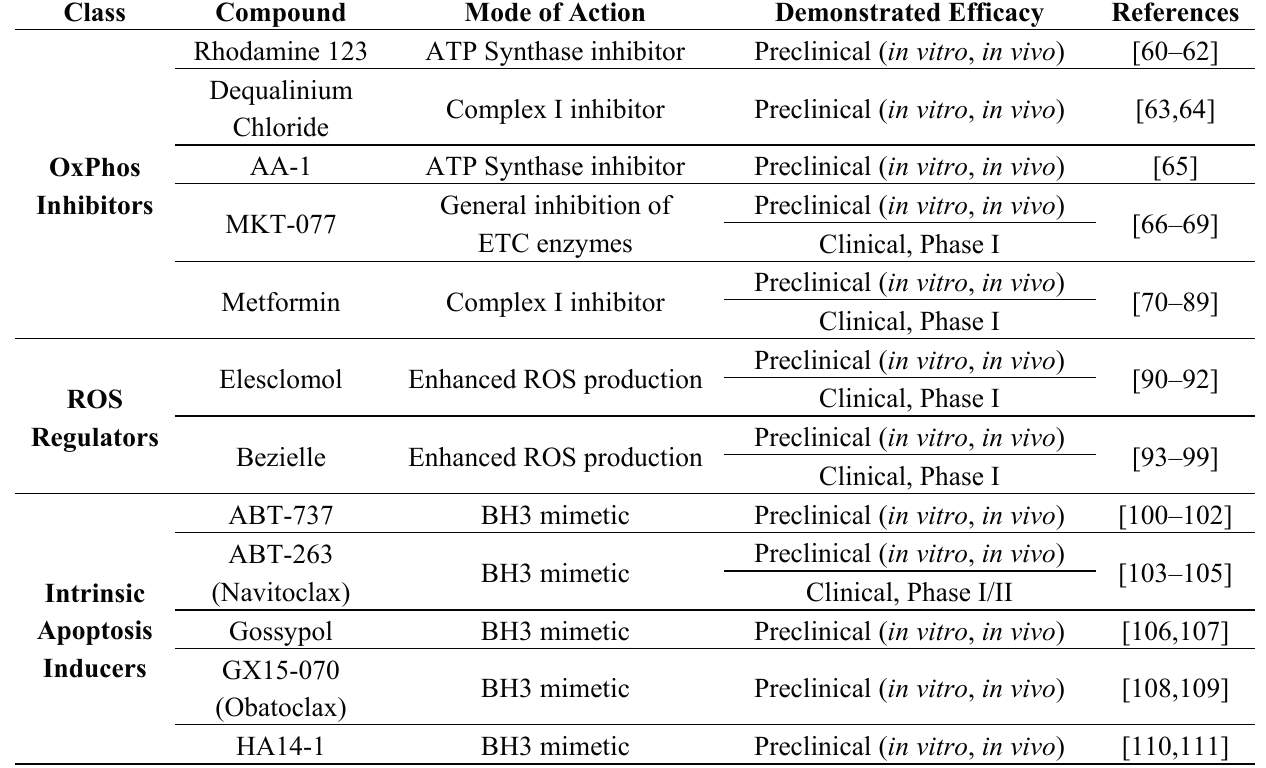
Table 1. Representative mitochondria-targeted compounds that exhibit selective cancer cell killing.